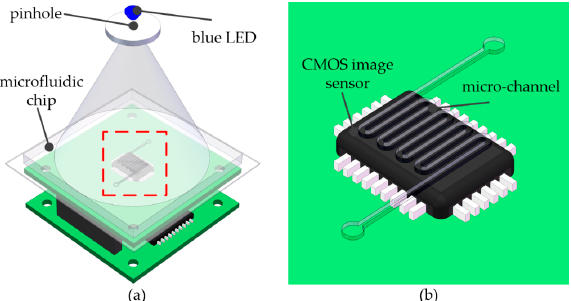
Figure 1. The structure of an on-chip flow cell counting system: ( a ) The general structure of the system; ( b ) the micro-channel on the image sensor (CIS) surface in the red box in ( a ).